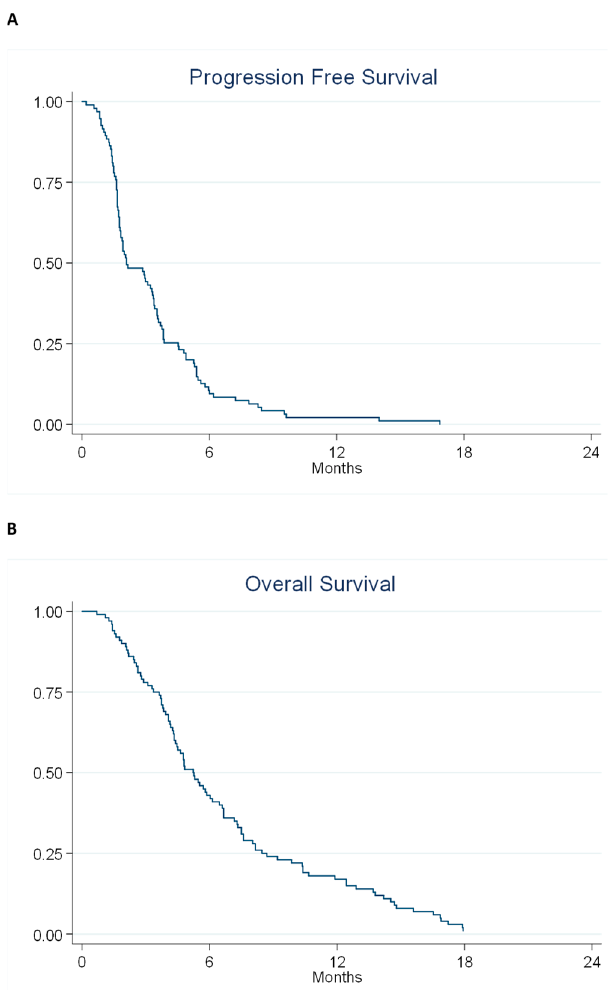
Figure 2. Kaplan–Meier Plots describing progression free survival ( A ) and overall survival ( B ) for the entire cohort. Table 3. Clinical Outcomes. Response rates are given for 75 patients evaluable for response. PFS = progression free survival at 2 months is the fraction of all patients alive without progression at the radiological evaluation after two cycles. Median PFS and OS = overall survival is given for the intention-to-treat population and reported using the Kaplan–Meier method.